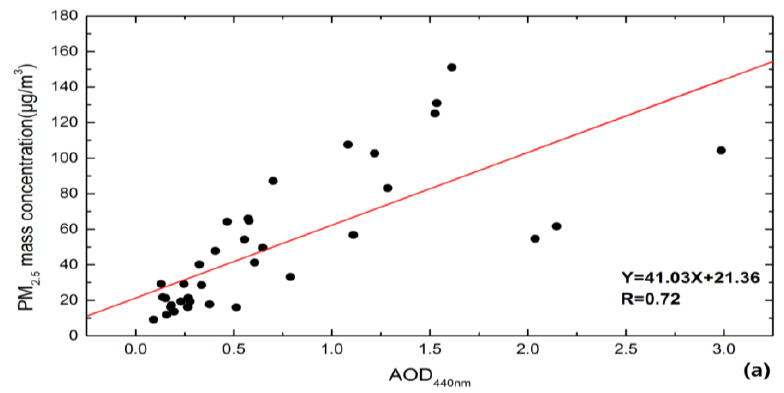
Figure 3. Cont. Figure 3. Cont